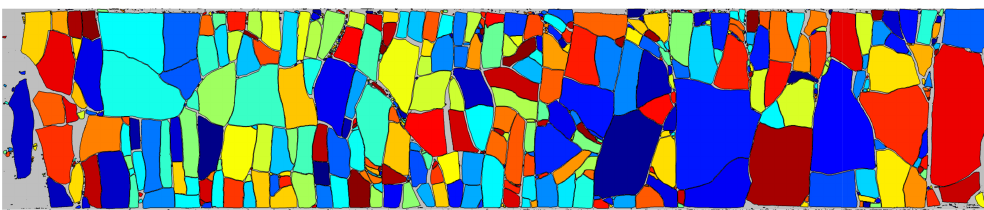
Figure 2. Example of a final result of the image analysis (test B, 1510), with identified ice floes marked by black contours and randomly selected colors. The ice edge is to the left, the beach to the right; the height of the image corresponds to the distance of 10m (tank width), gray areas are open water or ice that could not be identified (e.g., very small pieces). See Supplement Figs. S2 and S3 for all analyzed images.